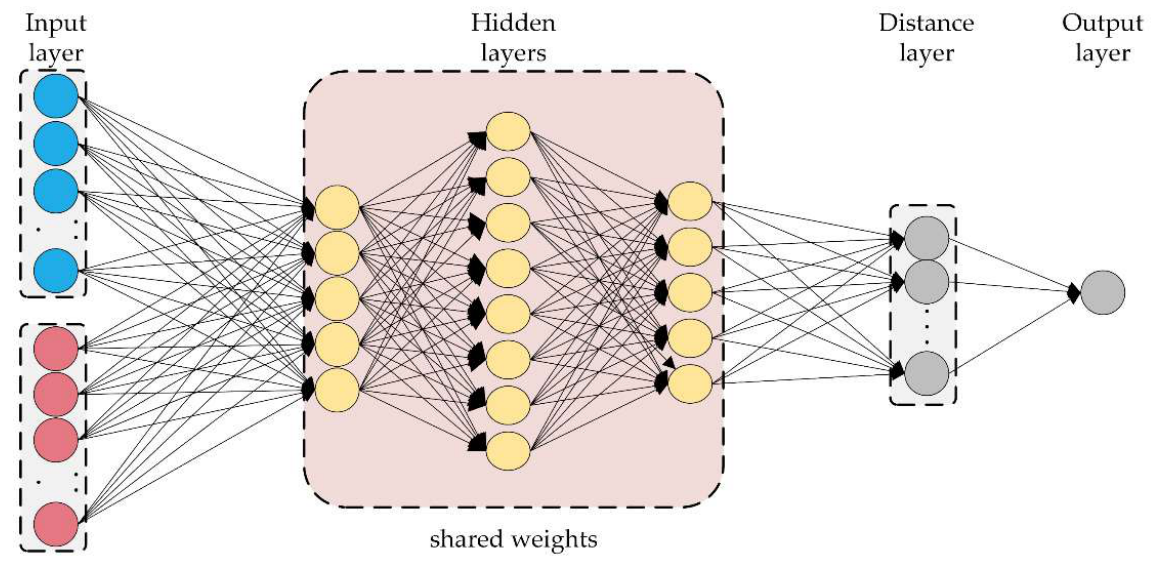
Figure 2. Typical Siamese network architecture.